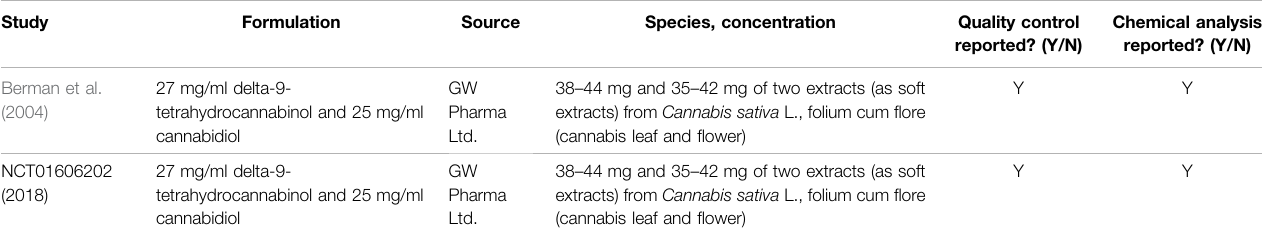
TABLE 2 | Patented formulations, botanical or chemical.